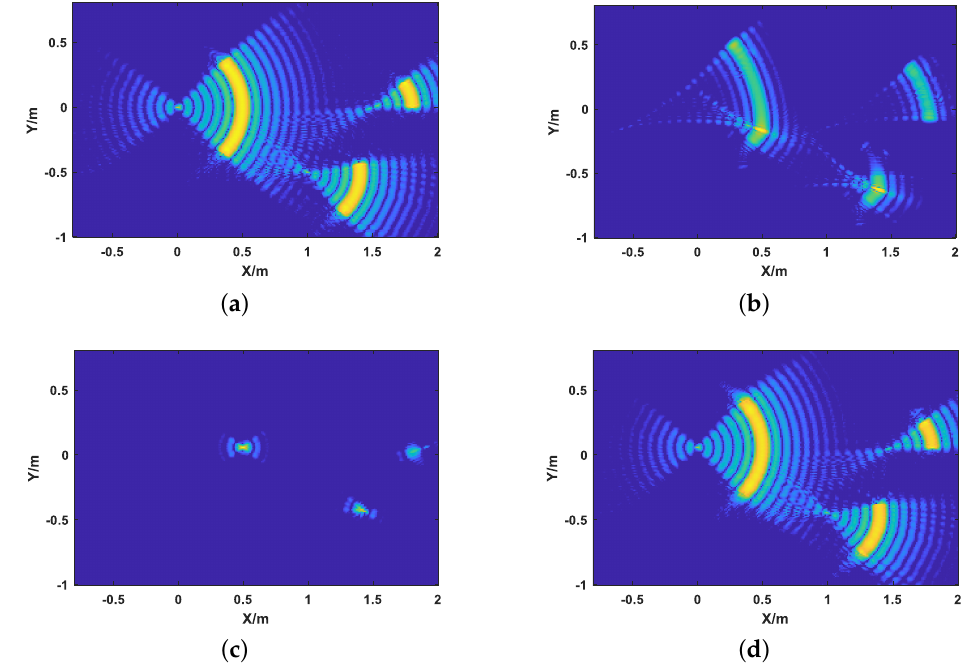
Figure 12. Simulation experiments of different situations and methods; ( a ) the imaging result of ideal trajectory; ( b ) the imaging result of real trajectory; ( c ) the imaging result of TAMs; ( d ) the imaging result of the proposed